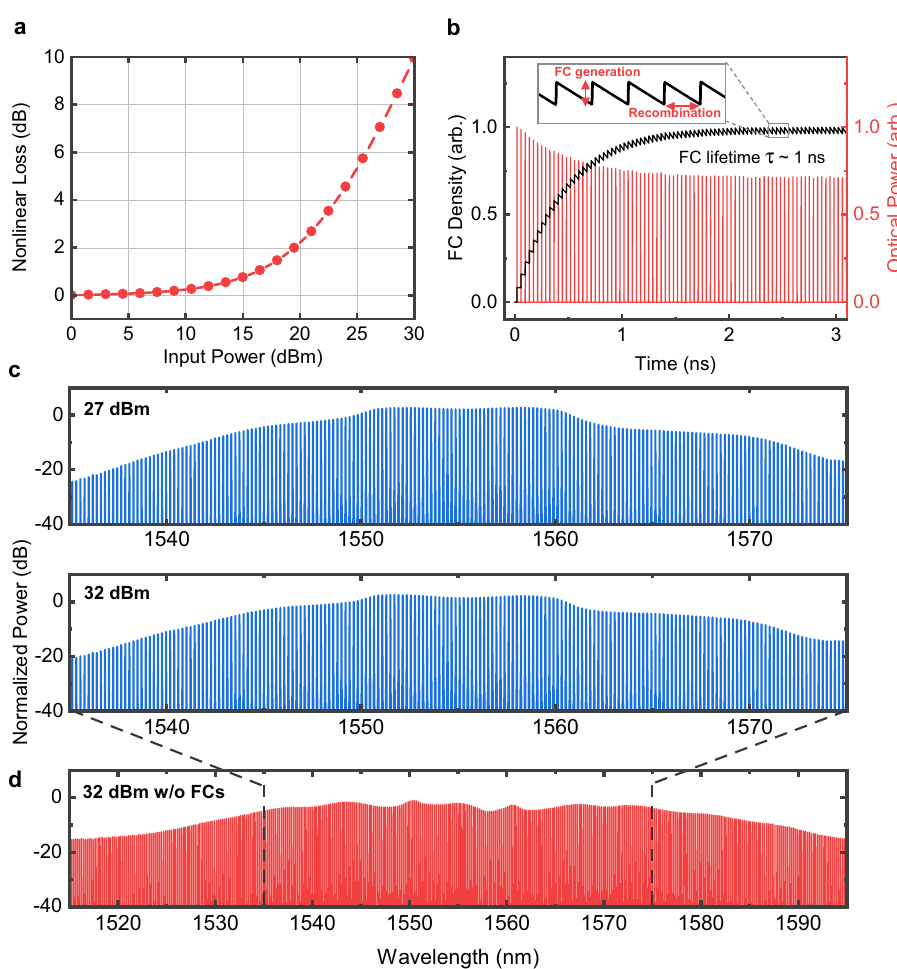
Fig. 4 Parametric frequency comb simulation including the effects of two-photon absorption and free carriers within the SCF. a Nonlinear loss induced by TPA and FCs as a function of average input power. b Free carrier density in the silicon core versus time (black), and the optical pulse train power versus time (red). Subsequent pulses in the 26 GHz pulse train increase the free carrier density before complete recombination can occur, reaching a steady state over several nanoseconds. c Simulated optical spectrum at the output of the SCF mixer, at 27 dBm and 32 dBm input power (top and middle respectively) and ( d ) at 32 dBm without free carriers. TPA is included in all three spectra, and insertion loss is